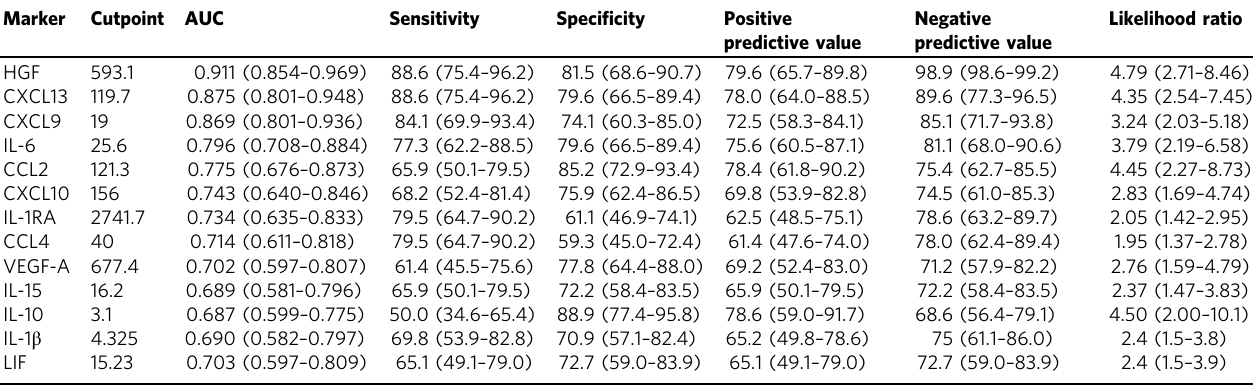
Table 1 Performance (area under the receiver-operating curve (AUC), sensitivity, speci fi city, positive and negative predictive values, and likelihood ratio) of each candidate markers dichotomized into lower than, higher, or equal to the cutpoint distinguishing ICU and non-ICU COVID-19 patients of the discovery cohort.